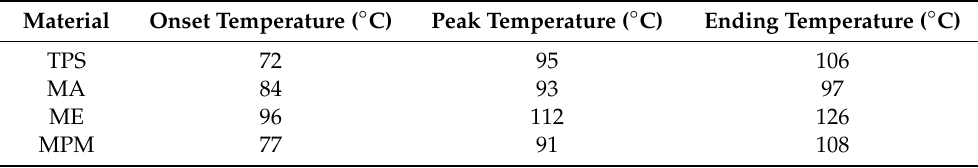
Figure 10. Differential scanning calorimetry (DSC) curves for TPS and its films blended with nopal mucilage (type MA, ME and MPM). Table 3. Thermal transition temperatures of TPS and its films blended with nopal mucilage (type MA, ME and MPM).